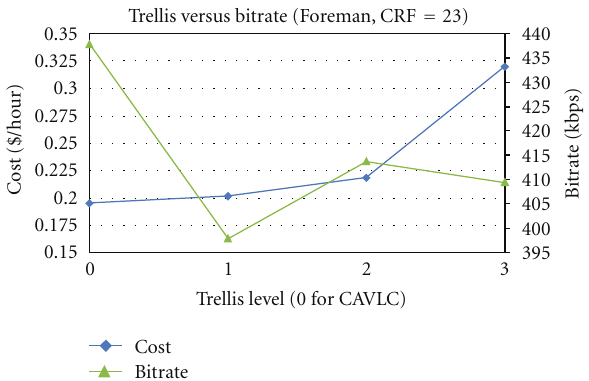
Figure 16: Encoding cost with varying Trellis levels under di ff erent CRF settings (Foreman).